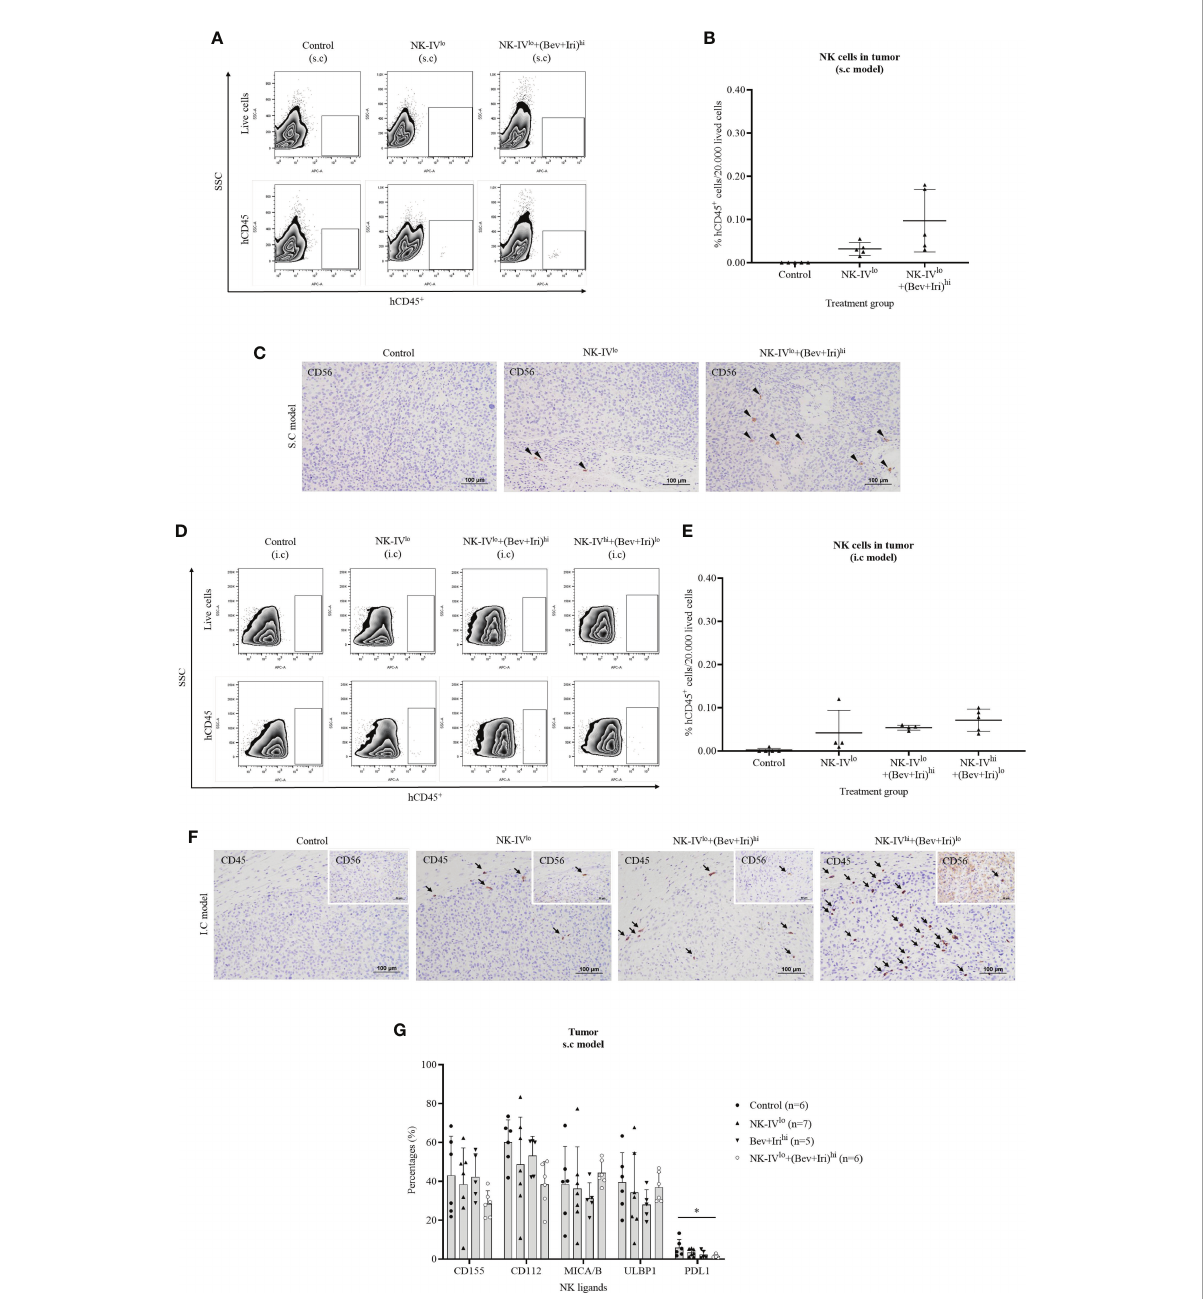
FIGURE 5 Presence of NK-HD cells in the tumor of s.c and i.c U87-bearing mice with or without treatment of NK-HD cells alone or NK-HD cells in combination with Bev plus Iri was con fi rmed through fl ow cytometry by hCD45 and immunohistochemistry (IHC) with hCD45 and hCD56 (A – F) . The expression levels of NK ligands such as CD155, CD112, MICA/B, ULBP1, and PDL1 on single tumor cells with or without treatment of NK-HD cells alone or NK cells in combination with Bev plus Iri were also clari fi ed using fl ow cytometry (G) . Data are presented by percentages of positive cells. FMO: live cells without staining NK ligand markers; NK-IV lo : intravenously injected NK-HD cells (1 × 10 7 NK cells); NK-IV hi : intravenously injected NK-HD cells (2 × 10 7 NK cells); Bev+Iri lo : intraperitoneally injected Bev (5 mg/kg) plus Iri (60 mg/m 2 ); Bev+Iri hi : intraperitoneally injected Bev (10 mg/kg) plus Iri (125 mg/m 2 ); U87: human GBM cell line. All data are shown as mean ± SD. p< 0.05